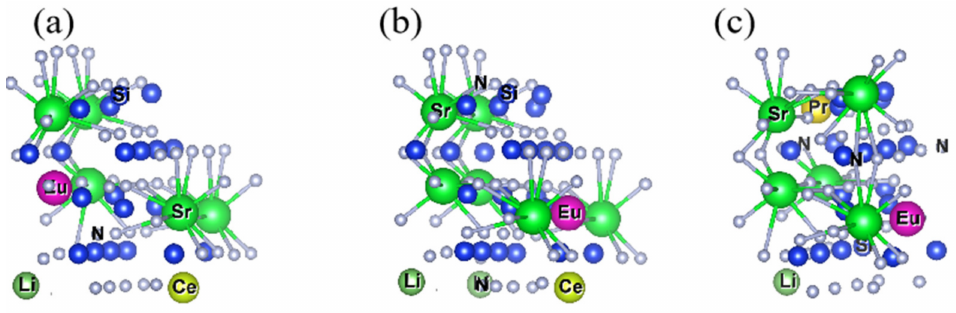
Figure 5. ( a – c ): [SrN] Coordination Polyhedron Diagram after Eu Sr1 Ce Sr1 Li Sr1 -Sr 2 Si 5 N 8 , Eu Sr2 Ce Sr1 Li Sr1